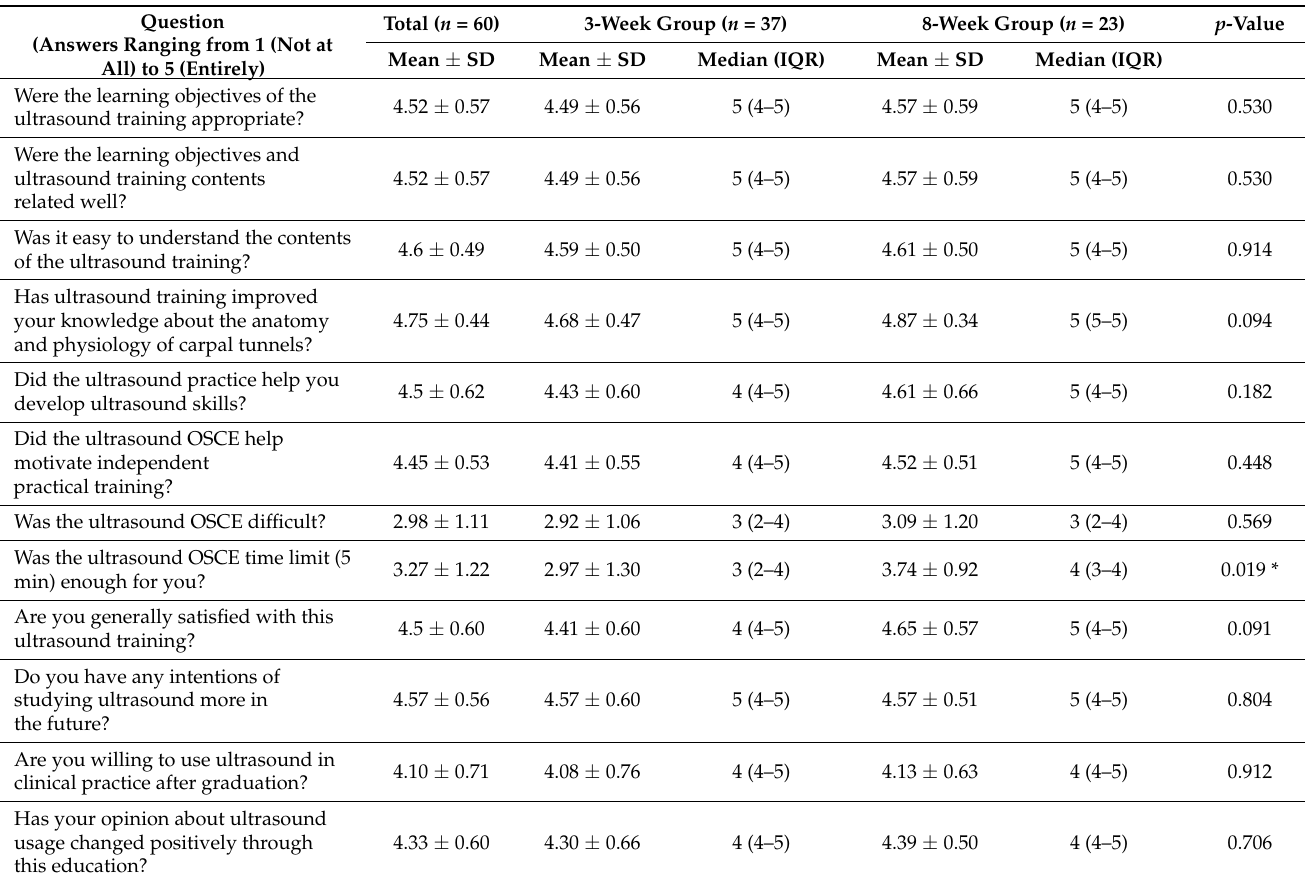
Table 1. Comparison of opinions on ultrasound training and OSCE in the 3-week group and 8-week group.